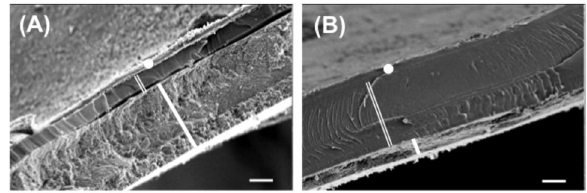
Figure 2. Scanning Electron Microscopy of the shell micro-scale structure of Notodiscus hookeri . The cross sections show a layered architecture of the shell and two contrasted phenotypes. The outer periostracum (full white circle), the innermost mineralised layer (ML, thick white line) and, in between, an organic layer (OL, double white line) ( A , B ), the OL/ML ratio may be reversed according to snail population, BUS ( A ) or BRA ( B ). Scale bars, 10 µm.